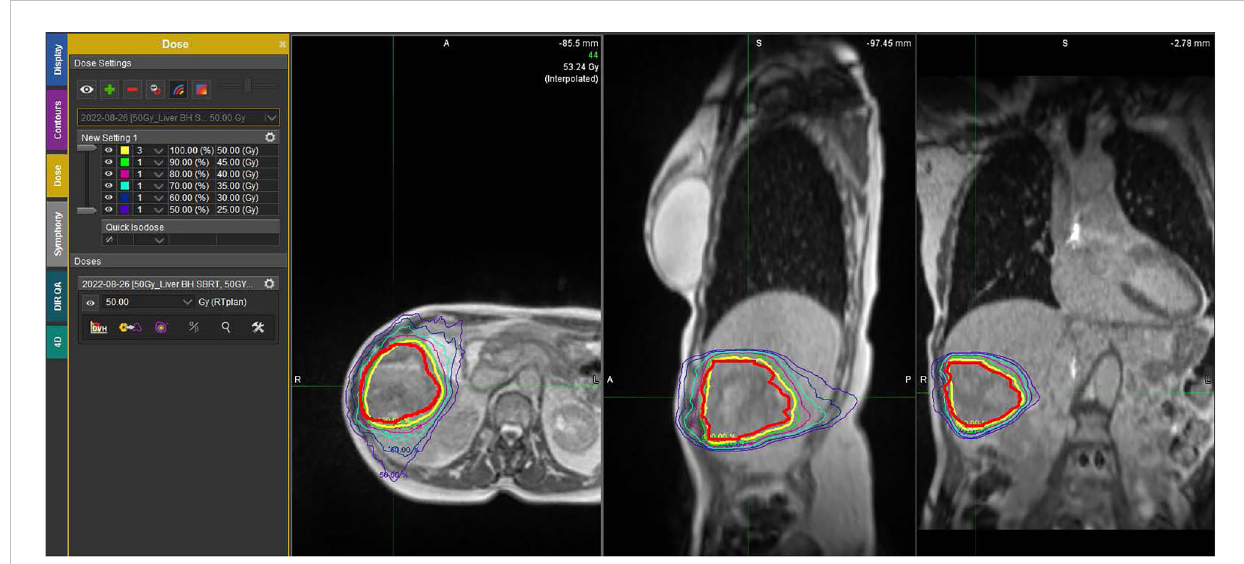
FIGURE 2 Example of the dose distribution on MRI from the SBRT course, composed of fi ve 10-Gy fractions delivered over consecutive days. The transverse, sagittal, and coronal views demonstrate the isodose levels from 50 Gy (prescription) to 25